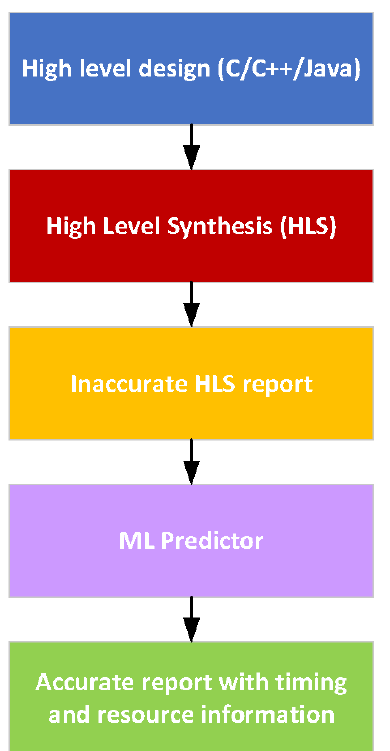
Figure 8. High-Level Synthesis using machine